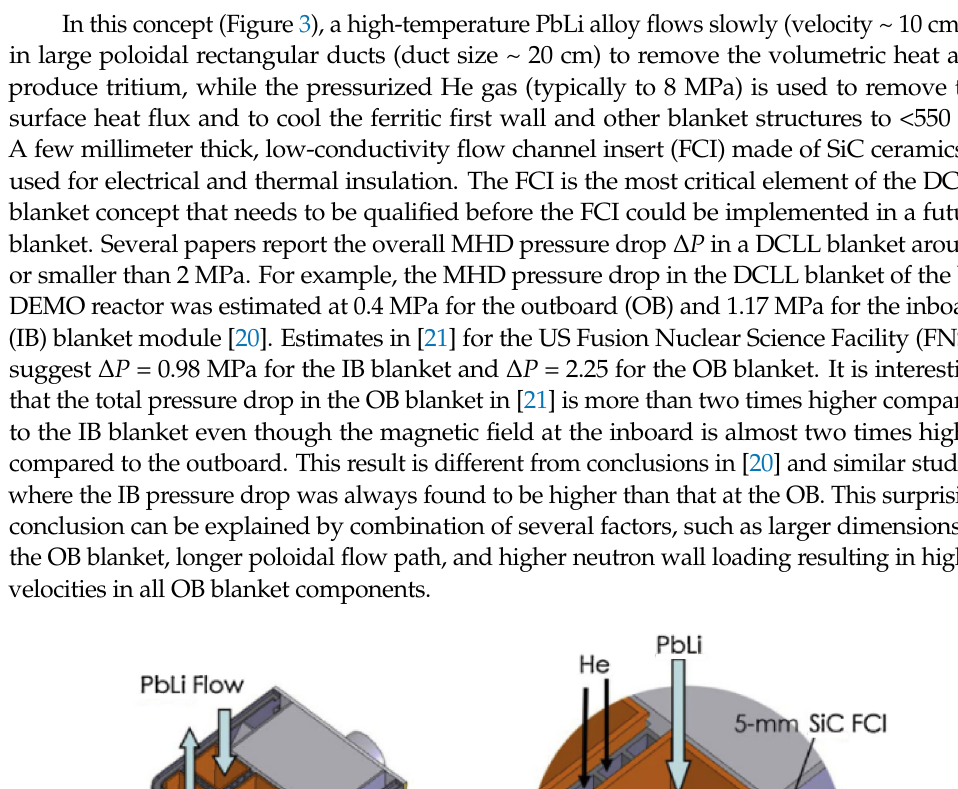
Figure 2. The EU HCLL blanket. ( a ) general view; ( b ) Pbi flow path [27].